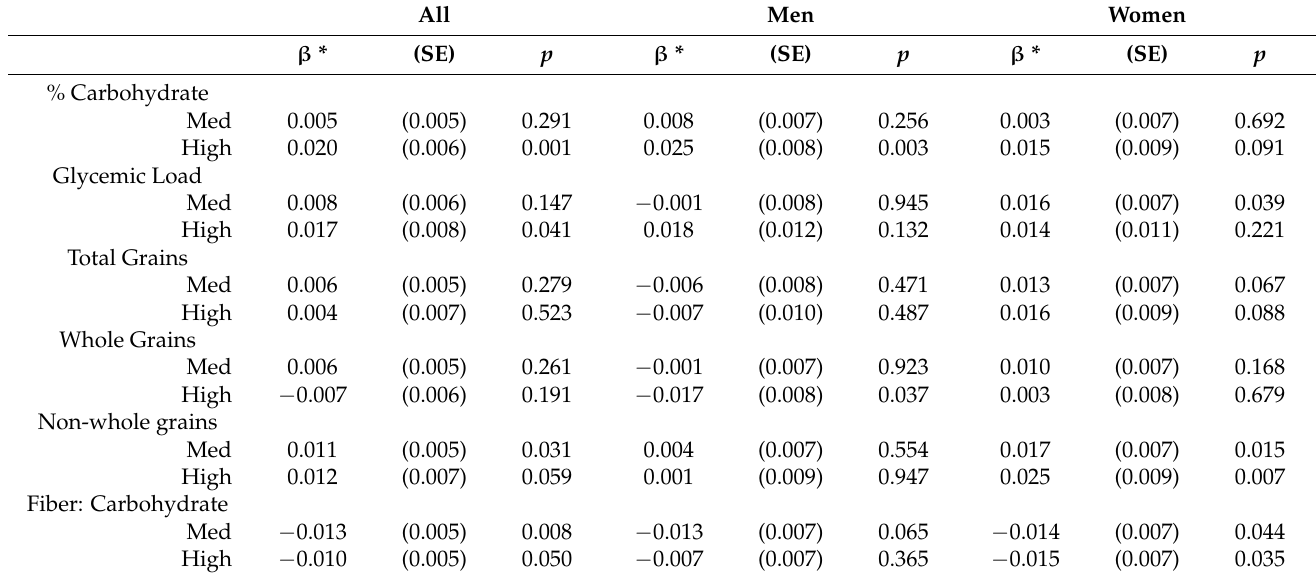
Table 2. Main effects of carbohydrate consumption on trajectories of frailty index. Men